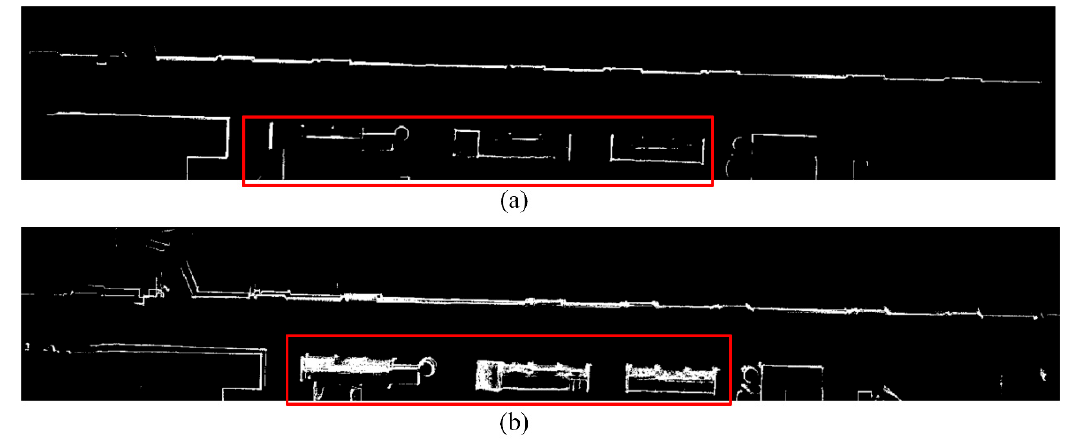
Figure 7. The occupancy likelihood maps of a long indoor corridor, with glass cabinets (shown in the red rectangles) on one side, generated by our proposed OWOLM ( a ) and the traditional OLM ( b ) approach. Brighter intensities indicate higher likelihood values.